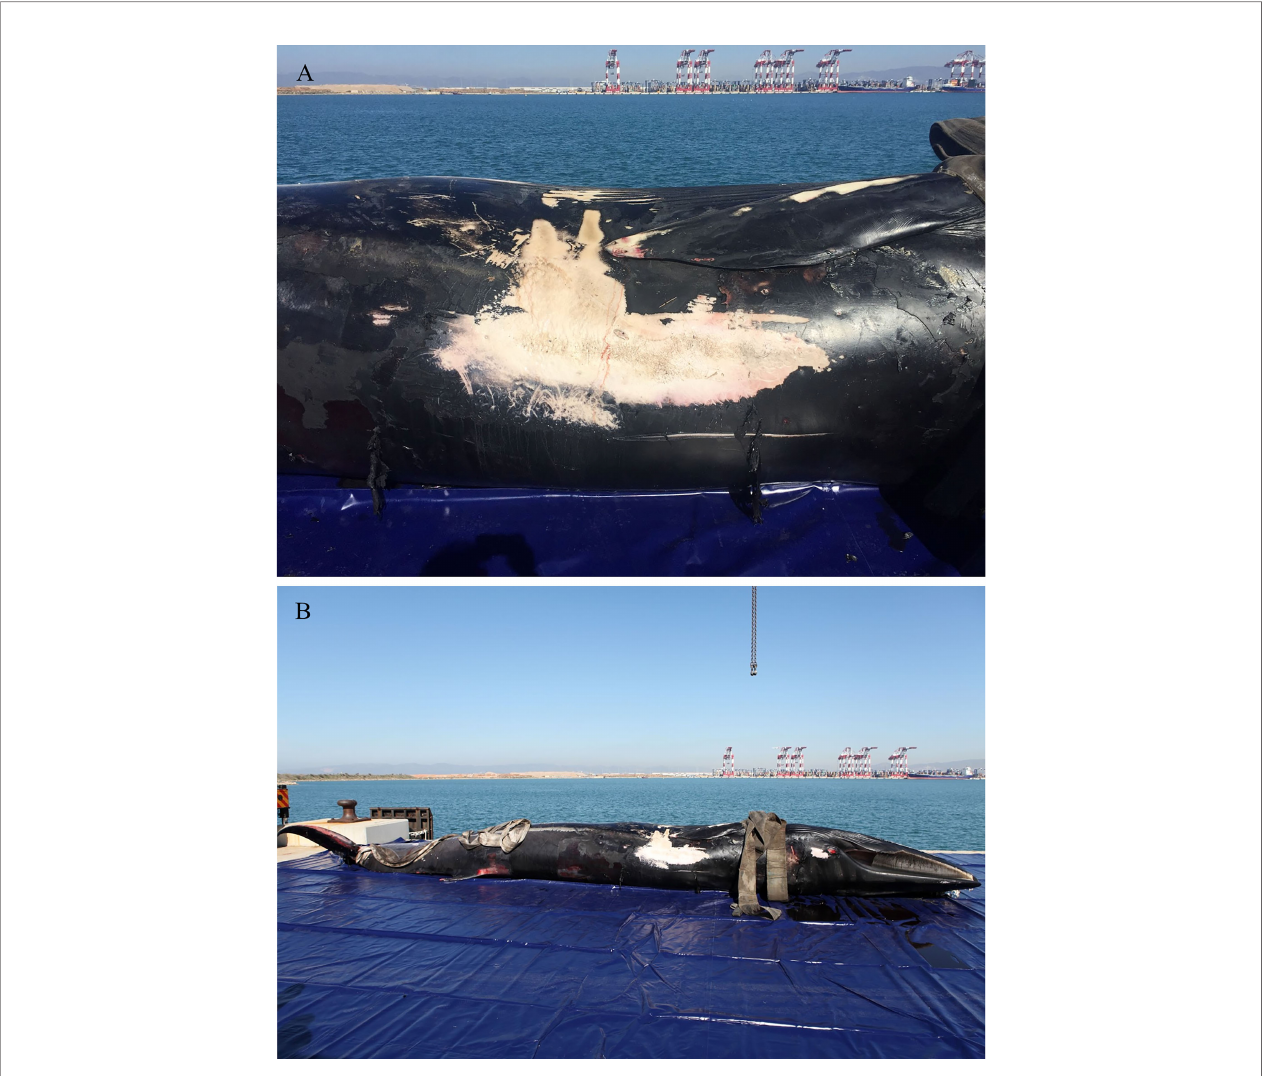
FIGURE 5 | Fin whale in Barcelona Port with evidence of ship strike on its leftright fl ank on the 14 April 2016. (A) A closeup view of the trauma and (B) an overall view of the whale. Photographs by Dr. Eduard